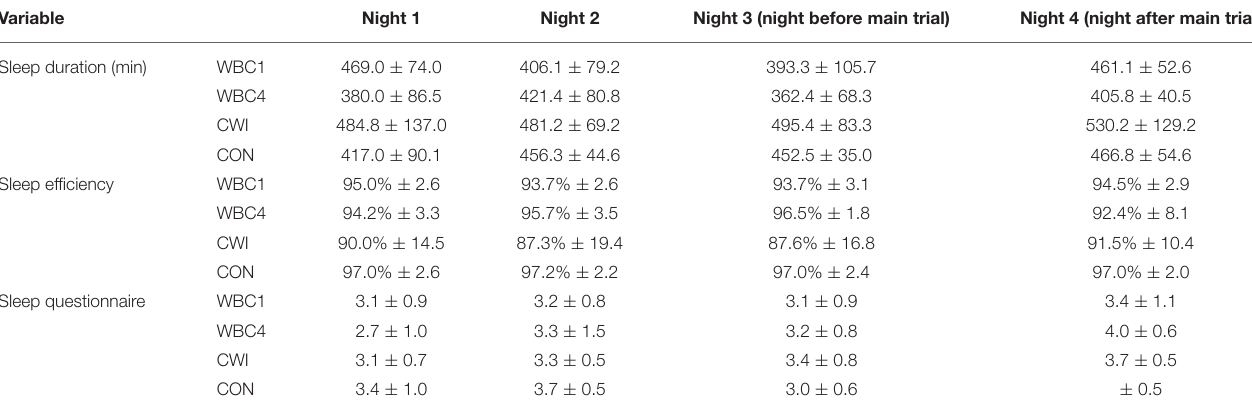
TABLE 4 | Sleep durations, % efficiency and questionnaire ratings over 4 consecutive nights for WBC1, WBC4, CWI, and CON groups.